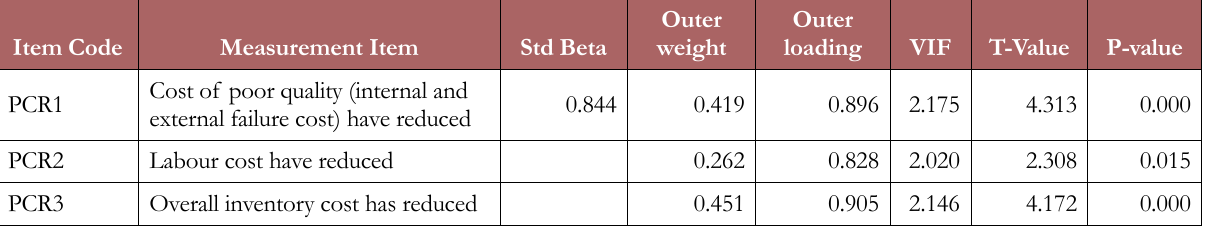
Table 6. Construct Validity of Formative